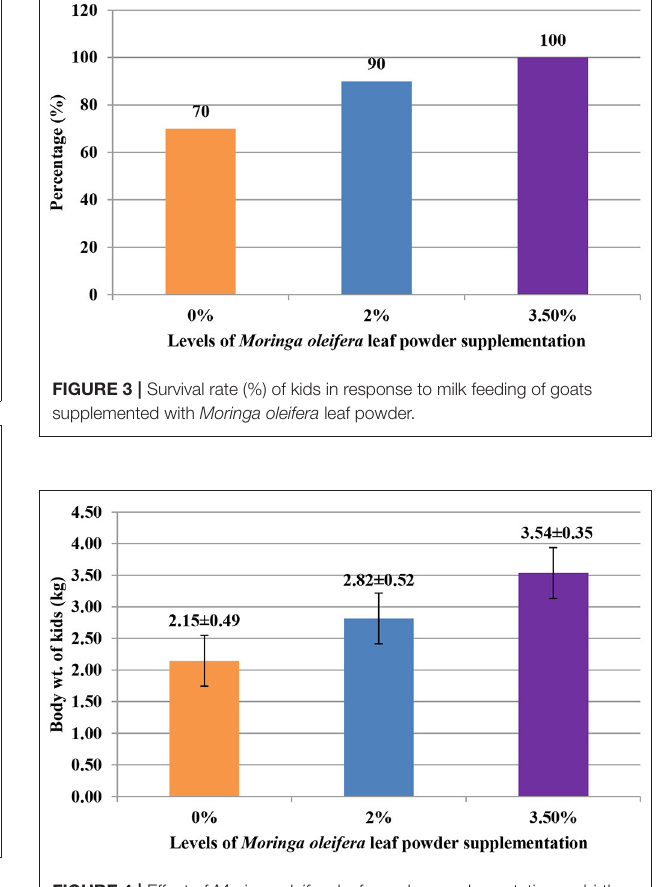
FIGURE 4 | Effect of Moringa oleifera leaf powder supplementation on birth weight (kg) of kids in Beetal